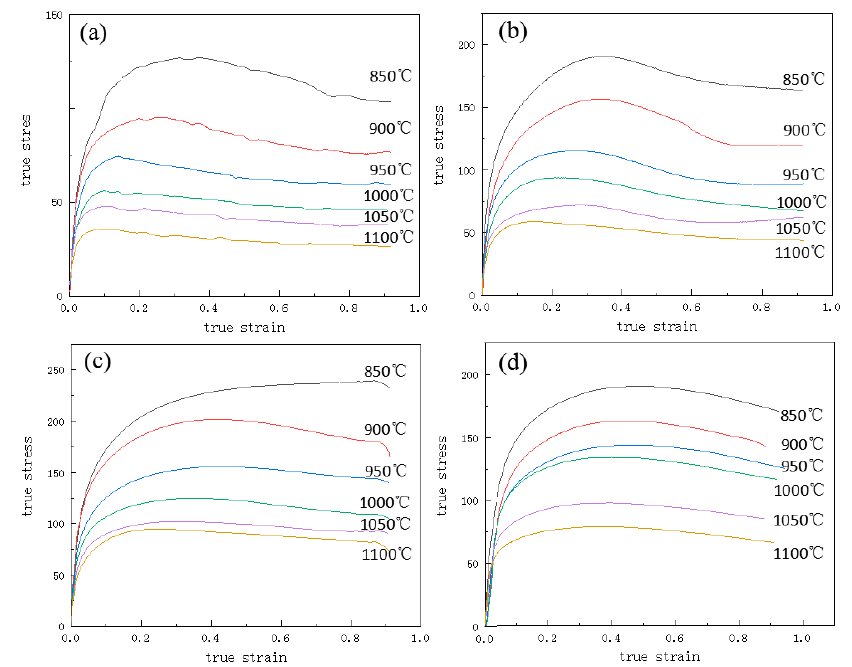
Figure 4. Flow stress curves under different conditions: ( a ) 0.01 s − 1 , ( b ) 0.1 s − 1 , ( c ) 1 s − 1 , ( d ) 10 s − 1 .